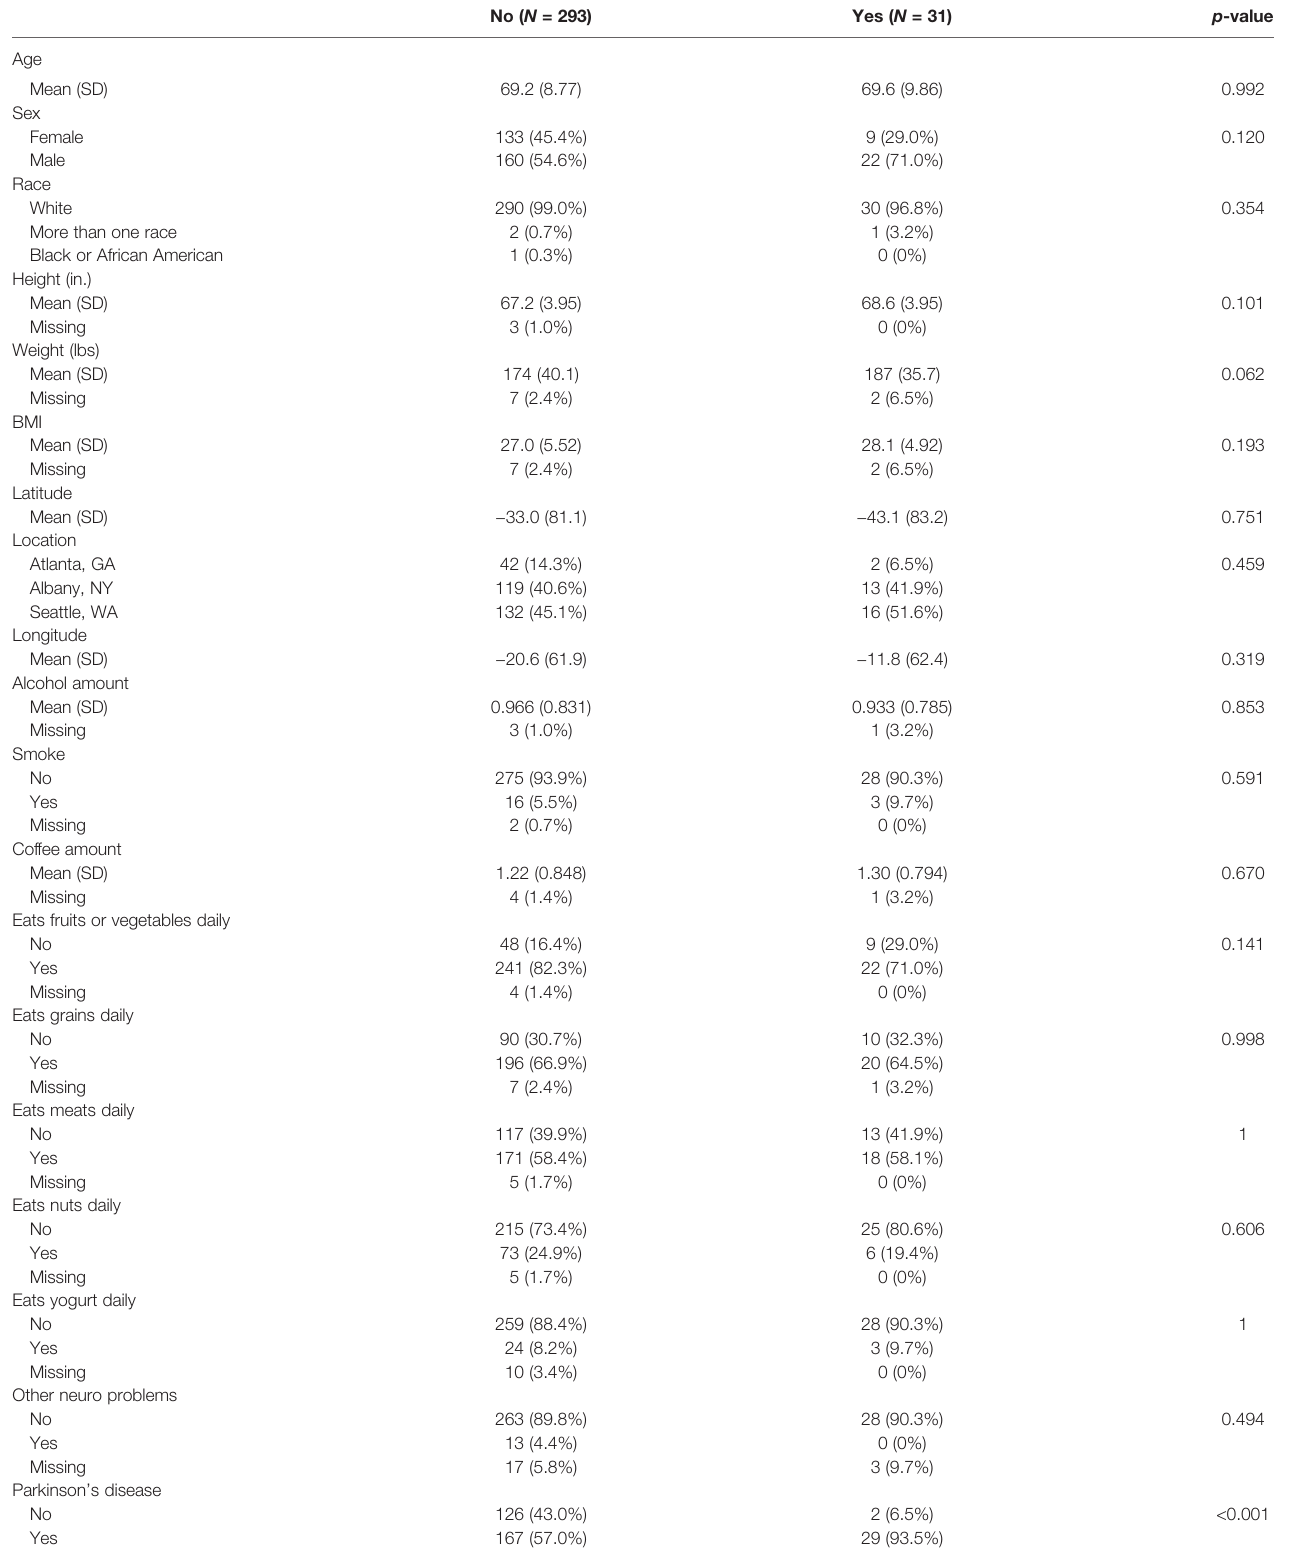
TABLE 1 | Comparing patients with and without constipation on demographic